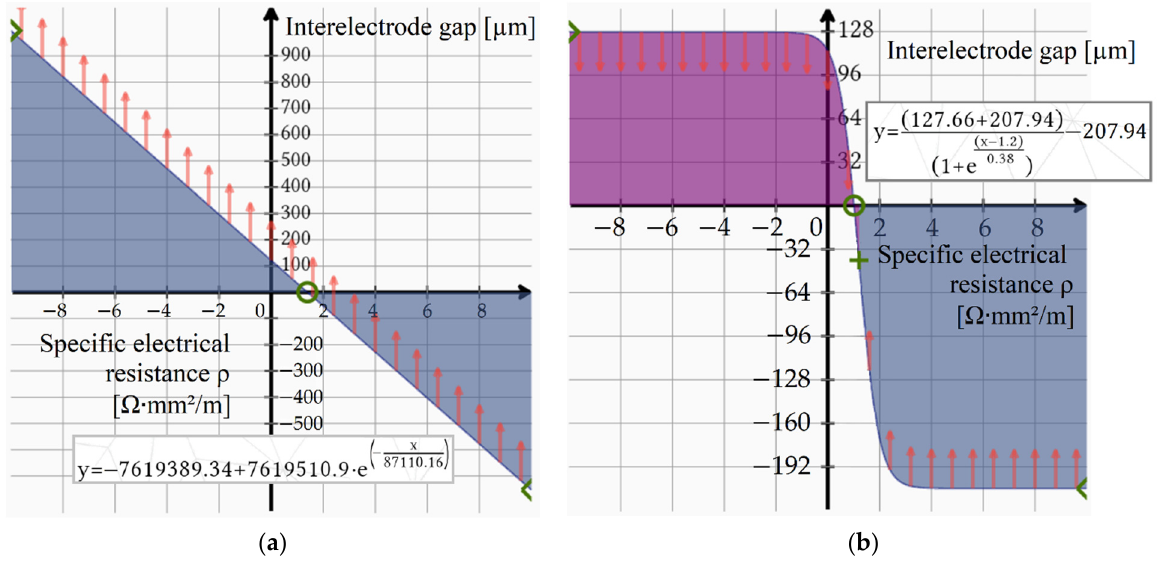
(cid:3118) : ( a ) : m (cid:2923)